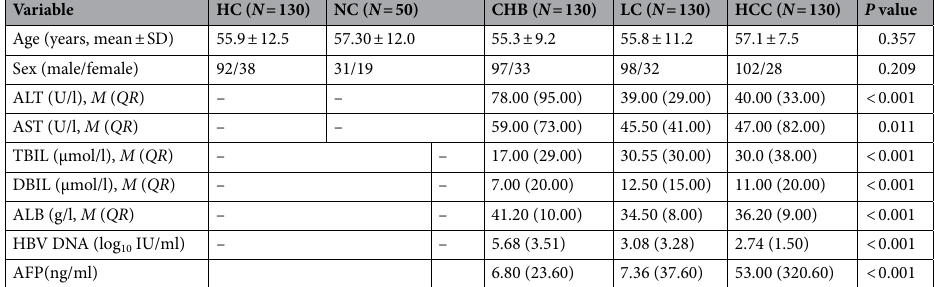
Table 1. Clinical characteristics of the subjects in each set. Data are presented as the mean ± SD (mean ± standard deviation). M (QR) median (quartile interval), AST aspartate aminotransferase, ALT alanine aminotransferase, TBIL total bilirubin, DBIL direct bilirubin, ALB albumin, HBV hepatitis B virus, HC healthy control, NC natural clearance, CHB chronic hepatitis B, LC liver cirrhosis, HCC hepatocellular